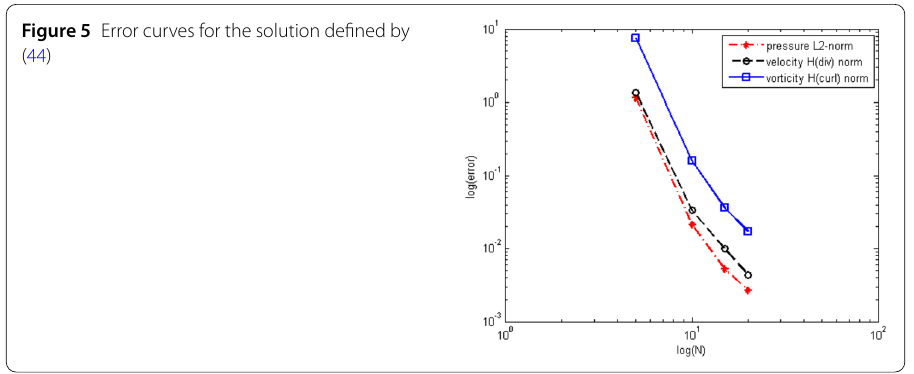
Figure 5 Error curves for the solution defined by